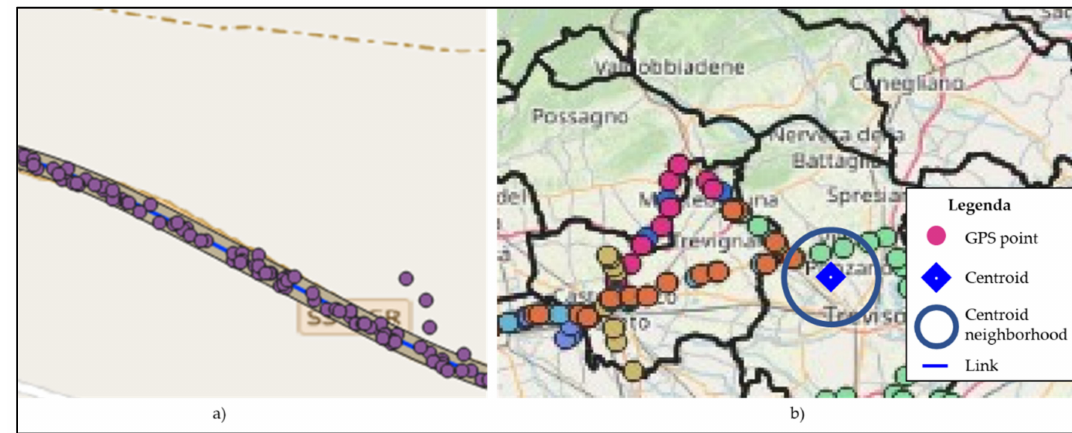
Figure 3. Example of link matching ( a ) and neighborhood at destination ( b